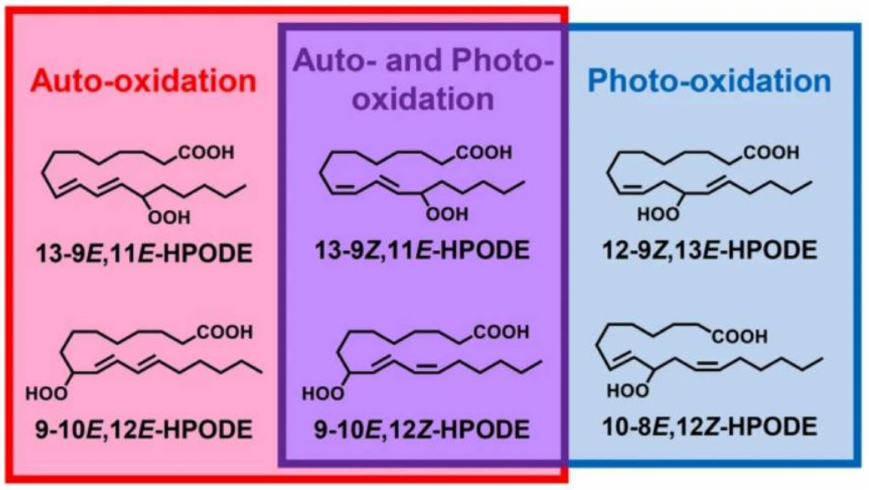
Figure 14. Chemical structures of six HPODE isomers (13-9 Z ,11 E -HPODE, 13-9 E ,11 E -HPODE, 12- 9 Z ,13 E -HPODE, 10-8 E ,12 Z -HPODE, 9-10 E ,12 Z -HPODE and 9-10 E ,12 E -HPODE)